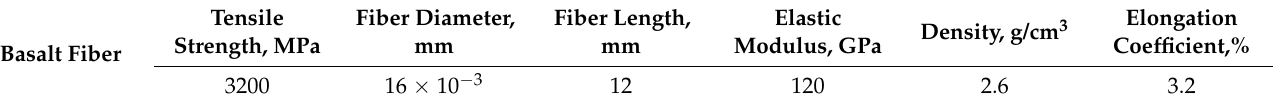
Table 6. Physical and mechanical properties of the